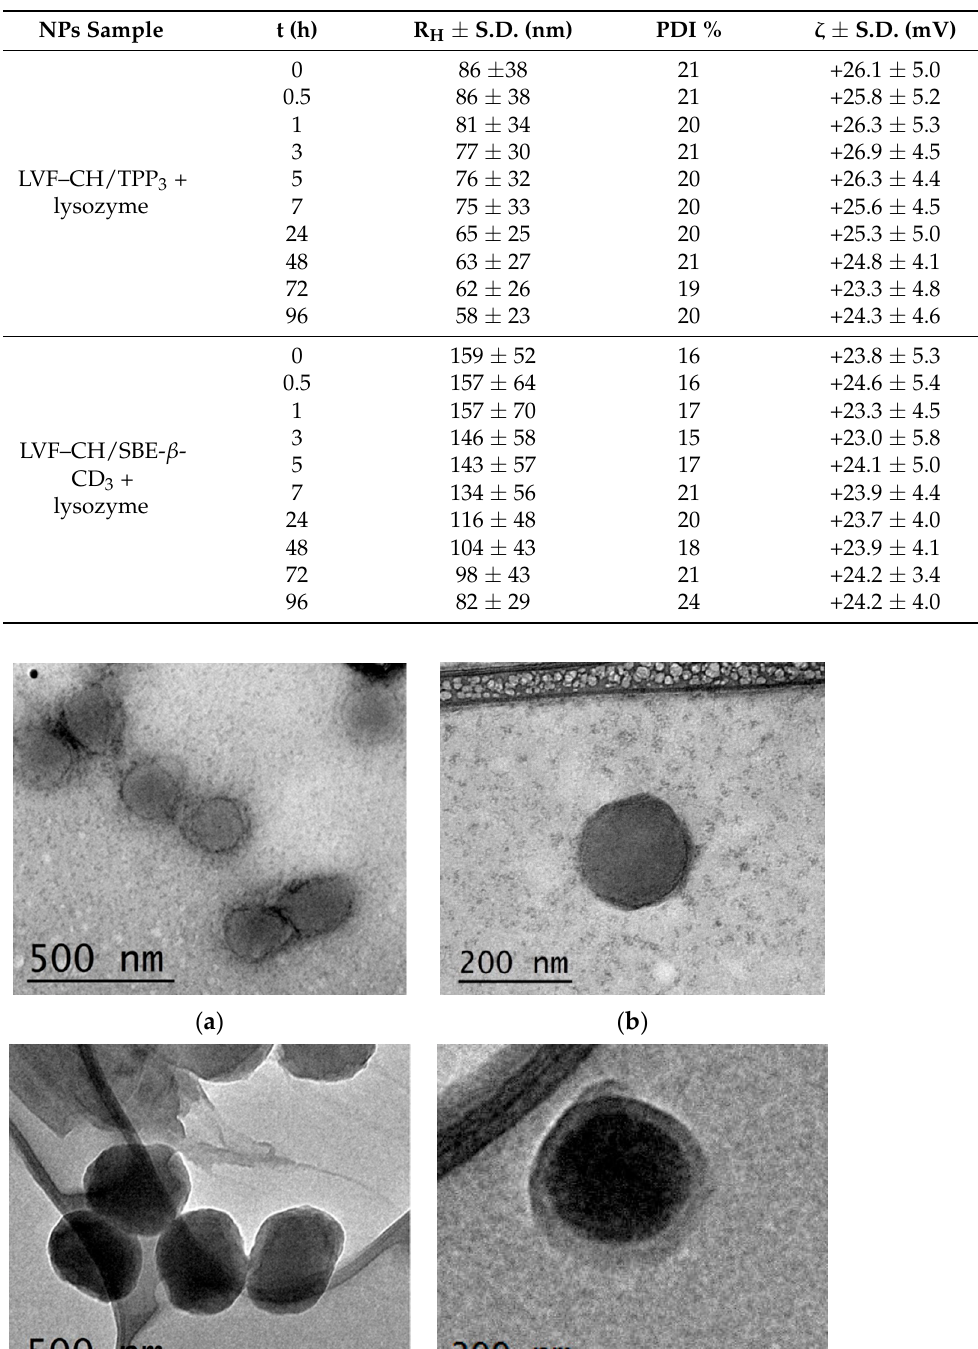
Table 4. Hydrodynamic radius (R H ) and zeta potential ( ζ ) of LVF–CH/TPP 3 NPs and LVF–CH/SBE- β -CD 3 NPs in the presence of lysozyme (1 mg/mL).